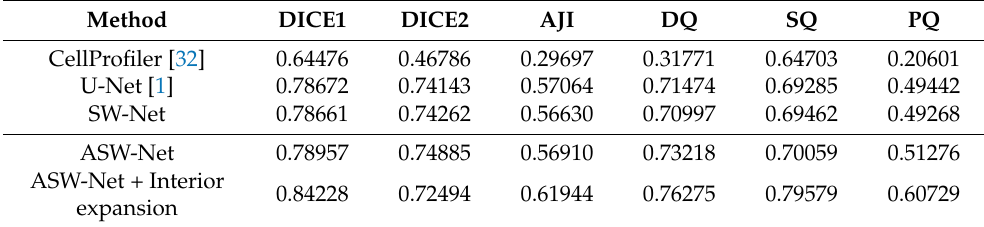
Table 2. The performance comparison on high SNR ganglioneuroblastoma